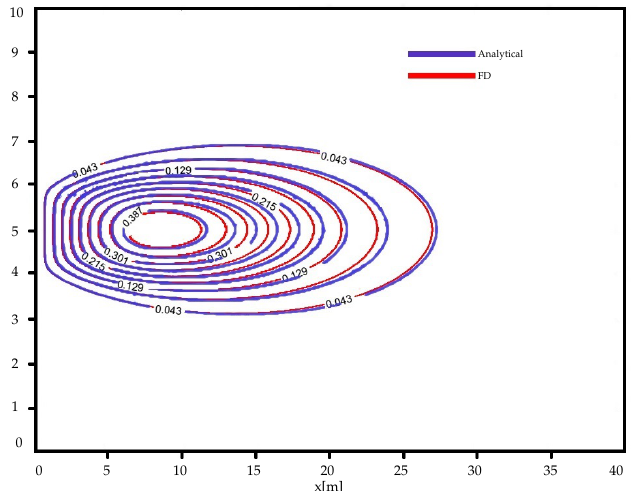
Figure 5. Comparison of the FD and Analytical solutions for two-dimensional transport. Figure 6a,b the concentration profile at point ( 5,4 ) Pe = 25 and ( 9,5 ) Pe = 45. Using analytical solution, we measured the root mean square error (RMSE) as defined be- low: